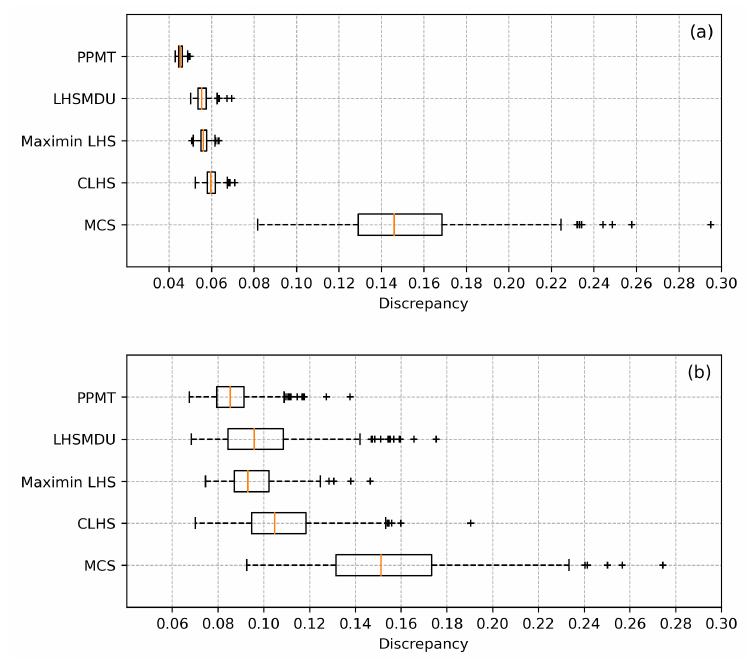
Figure 12. The box plots of the WL 2 statistics: ( a ) uncorrelated case, and ( b ) correlated